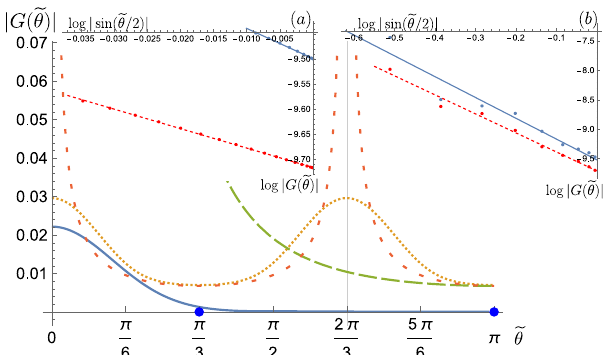
Fig. 3 Edge Green ’ s function corresponding to the Laughlin ’ s (blue line) and the root (orange dotted line) state, for eight particles. Both ð sin ð ~ θ = 2 ÞÞ (cid:4) 3 (green dashed line) and sin ð 3 ~ θ = 2 Þ (red dashed line) laws are also shown. The latter is a better approximation of j e ρ j in a broader range around π . In the vicinity of blue points Stirling ’ s approximation is valid. Insets: log j G ð e θ Þj as a function of log j sin ð e θ = 2 Þj in the range a [0.967, 1] for sin ð e θ = 2 Þ , for N = 8 (red dashed line) and [0.991, 1] for N = 7 (blue line); b [0.6, 1] for both N = 8 (red dashed line) and N = 7 (blue